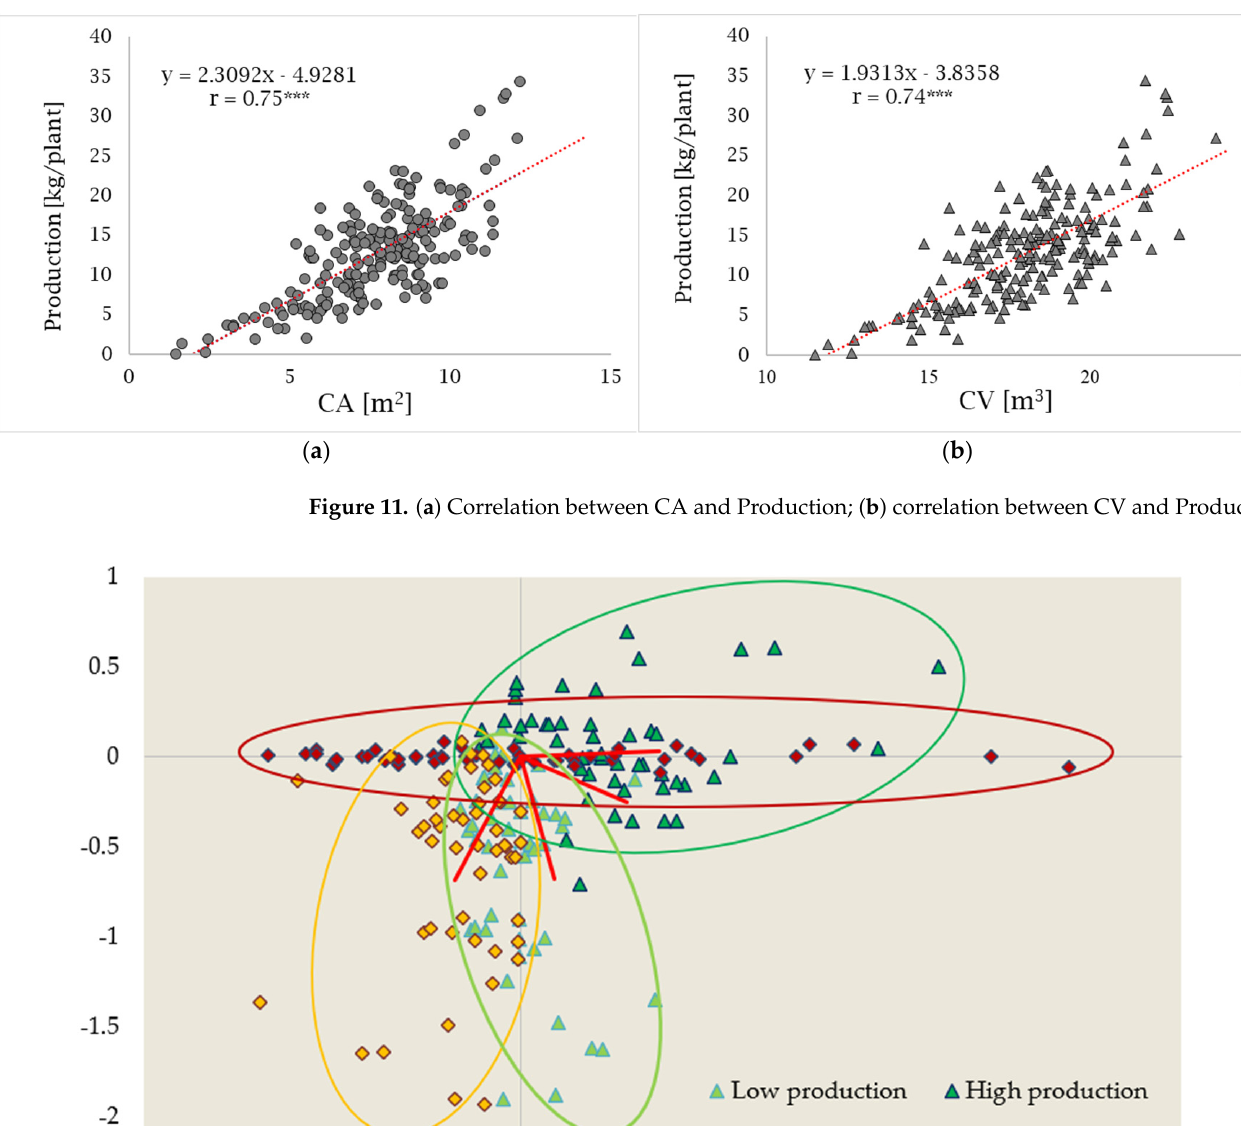
Figure 12. Principal Component Analysis (PCA) of high and low CA and production.